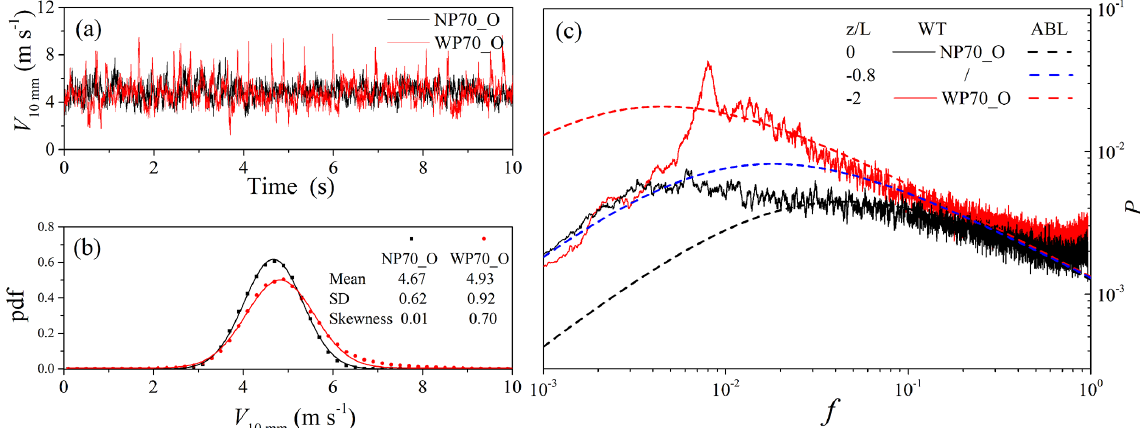
Figure 2. (a) A section of 10s of the V 10mm time series for the NP70_O and WP70_O runs, (b) probability density functions of V 10mm (estimated using a time series of 300s) and (c) normalized power spectra of V 10mm for WP70_O and NP70_O compared with field-observed power spectra in the atmospheric boundary layer (Kaimal et al., 1972). Z 0WT is 1.33 × 10 − 2 mm, and Z 0ABL is set to 3.10mm (Wiernga, 1993).